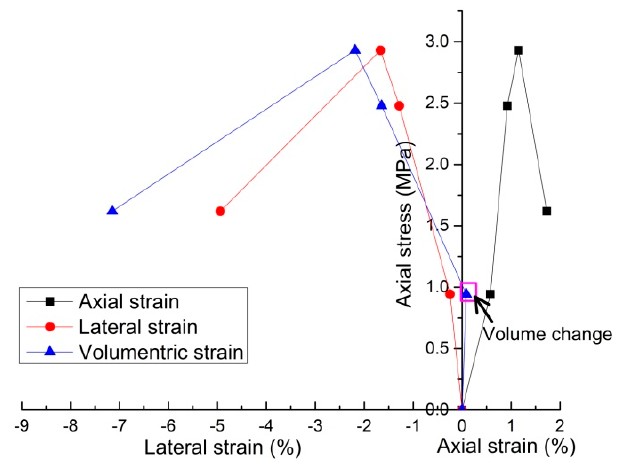
Figure 15. The axial, lateral, and volumetric stress strain curves at the five CT scanning points.